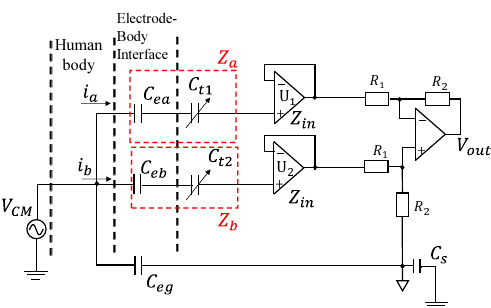
Figure 2. Common-mode (CM) equivalent circuit of digitally tunable capacitor series (“DTC